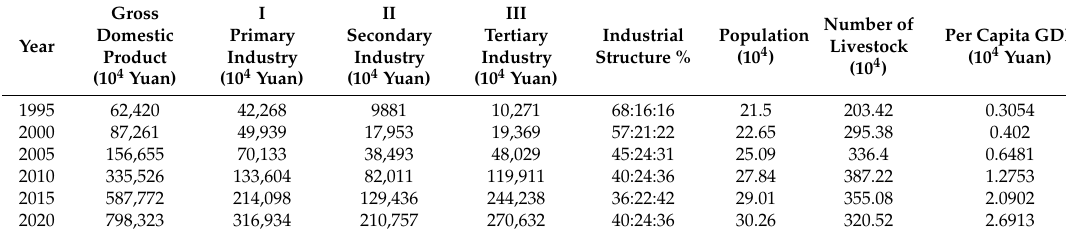
Table 1. Socioeconomic data for ZP, from 1995 to